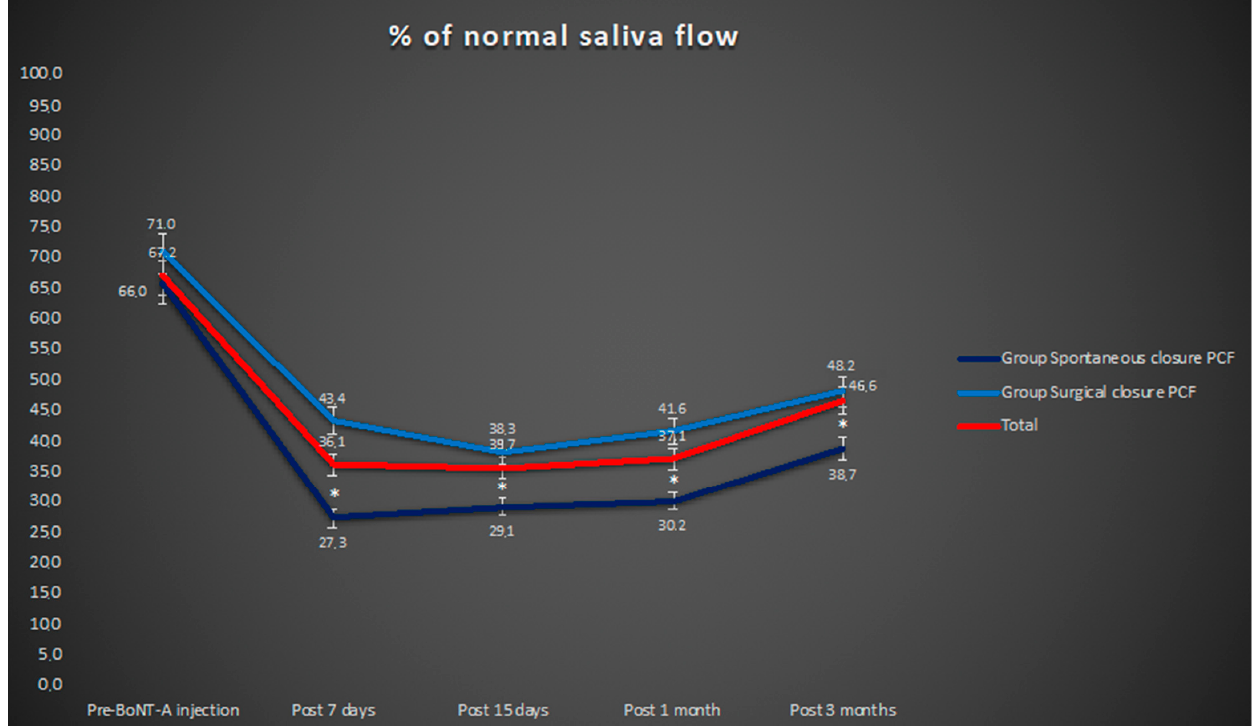
Figure 1. The mean percentage of normal saliva flow observed in all cases, in the group of subjects who demonstrated a spontaneous closure of PCF and in the group of subjects treated surgically; * p < 0.05 group PCF spontaneous closure vs. group PCF surgical closure.